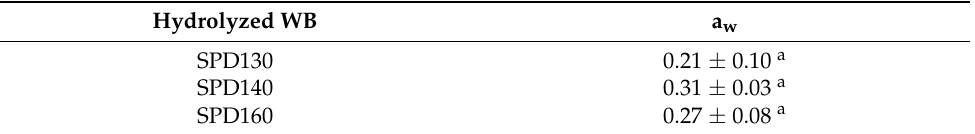
Data are mean values ± standard deviation of two replicates. Different lowercase letters show significant differences between samples (one-way ANOVA, post hoc Duncan’s test, p ≤ 0.05). Abbreviations: hydrolyzed